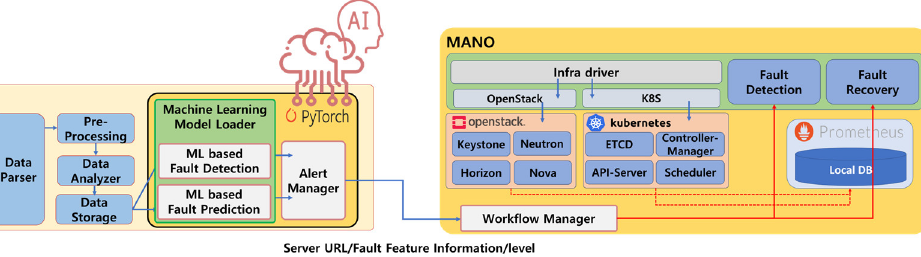
Figure 16. Recovery action based on Anomaly Score.